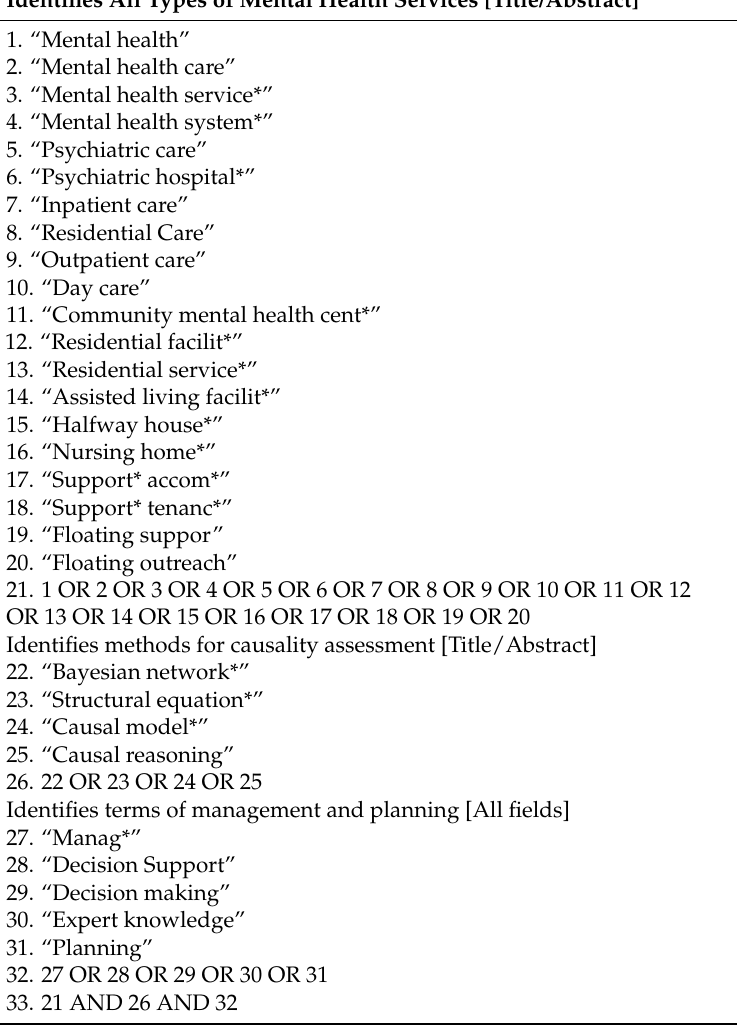
Table 3. Search strategy piloted in MEDLINE–PubMed